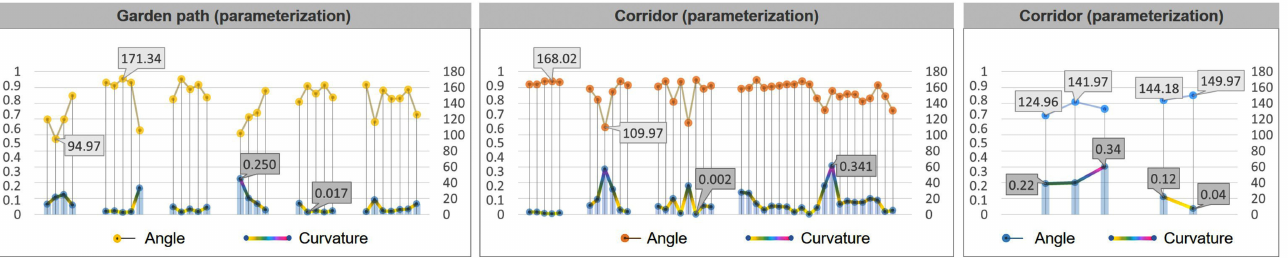
Figure 16. The path generated by parameterization and its angle and curvature. Evaluated from the viewshed aspect, the parametrically generated road has a larger viewshed visible area than the original road. The maximum areas of the original